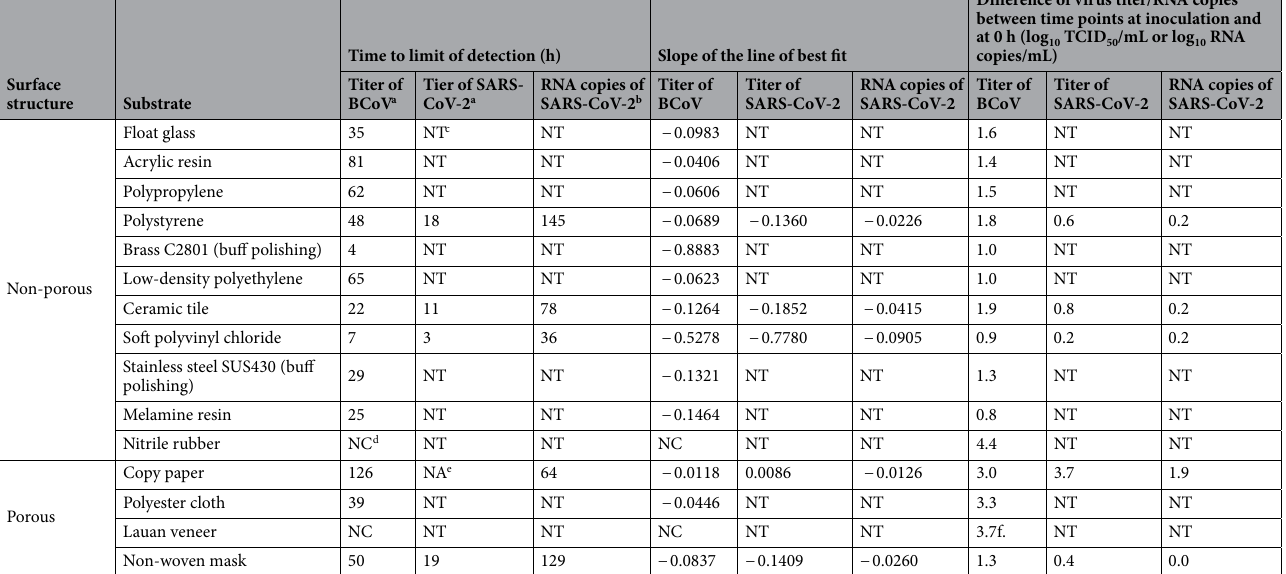
Table 2. Comparison among time to limit of detection for BCoV and SARS-Cov-2. a Calculation with a detection limit of 1.0 log 10 TCID 50 for all substrates. b Calculation with a detection limit of 4.8 log 10 RNA copies/mL for all substrates. c Not tested. d The line of best fit cannot be drawn because virus titers were detected at no more than two points. e The line of best fit was not applicable due to the upward slope. f Calculation with